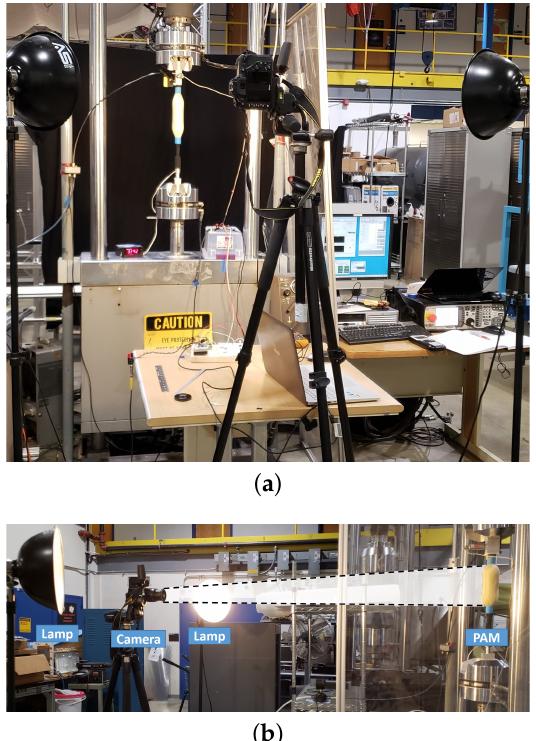
Figure 7. ( a ) Front, and ( b ) Side views of the photogrammetric test setup (PAM, camera, lights, and